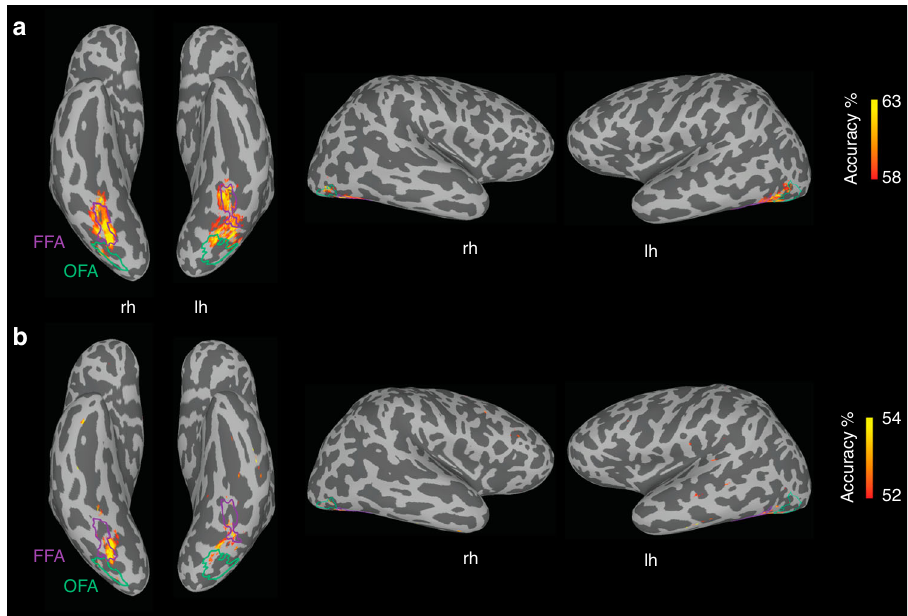
Fig. 3 Localized sensitivity to illusory faces. fMRI cross-decoding searchlight results for a human faces vs. objects and b illusory faces vs. objects. For both comparisons, the location of greatest decoding accuracy is within ventral temporal cortex and overlaps with FFA particularly in the right hemisphere. The location of greatest cross-decoding for illusory faces vs. matched objects (across exemplars) is a subset of the area for human faces vs. objects. For illustration, the approximate boundaries of functionally de fi ned FFA (purple) and OFA (green) as de fi ned by the location of overlapping surface nodes across individual participants (node inclusion threshold = 3/16 participants for OFA, 4/16 participants for FFA) are drawn on this example in fl ated surface for comparison with the searchlight